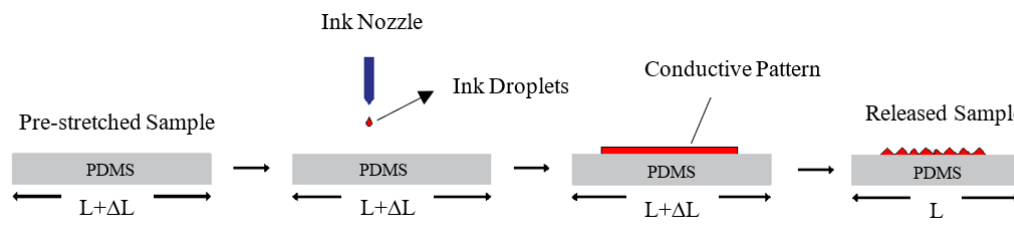
Figure 1. Schematic diagram of the axial pre-stretching technique adapted from Reference [18].